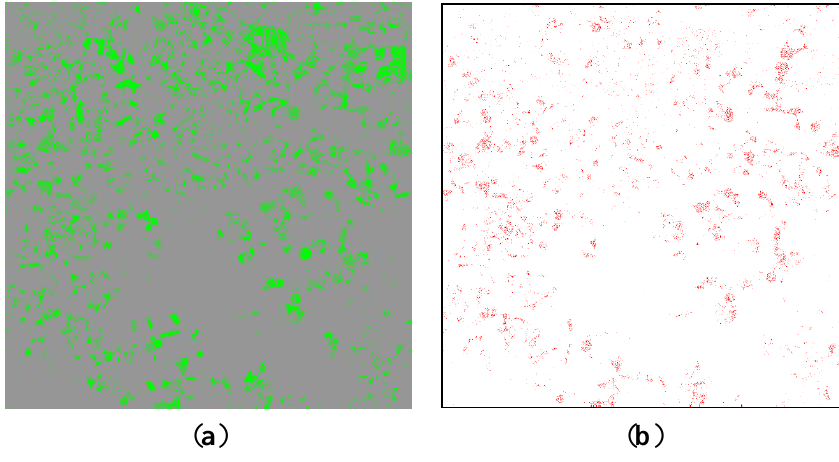
Figure 19. Spatial distribution of Dense Dark Vegetation (DDV) pixels; ( a ) distribution of the nominal scenario having no spectral shifts, where green dots represent DDV pixels; ( b ) difference image where red dots represent pixels classified as DDV pixels in the nominal case ( a ), but not classified as DDV in the +2.0 nm shift